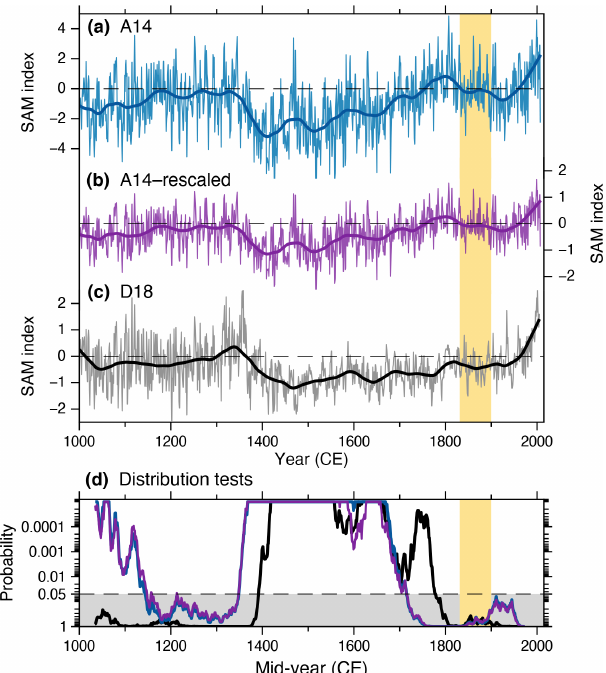
Figure 11. SAM index in the CSIRO Mk3L transient last millen- nium simulations (a–c) and the significance of negative shifts in 70- year windows of annual SAM distributions through time relative to a 70-year pre-industrial reference period (1831–1900CE) (d) . The 70-year loess filter of the SAM index of (a) the OGS simu- lations, (b) OGS-x2 simulations, and (c) OGS-Shapiro simulations (as in Fig. 8). The ensemble mean is shown as a thick line, and individual ensemble members are shown as thin lines. SAM in- dices are shown relative to their 1900–1999CE climatology (dashed horizontal lines). (d) Distribution tests on ensemble means using a Wilcoxon rank-sum test of sliding 70-year windows relative to the pre-industrial reference period (1831–1900CE; vertical yellow shading), where colours match the SAM simulations shown in pan- els (a) – (c) . Time series show the probability for the distribution of sliding test windows being more negative than the distribution in the reference interval. Values of P < 0 . 05 are shown with a white background, while values of P ≥ 0 . 05 are shown with a grey back-